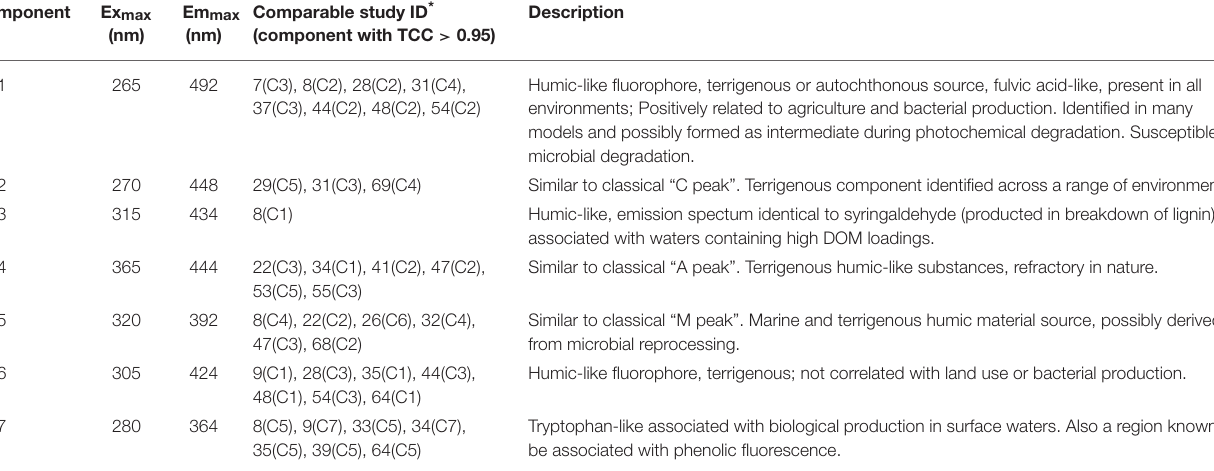
TABLE 3 | Excitation and emission maxima (Ex max /Em max ) of the seven components identified using parallel factor analysis of DOM fluorescence (Figure 2).